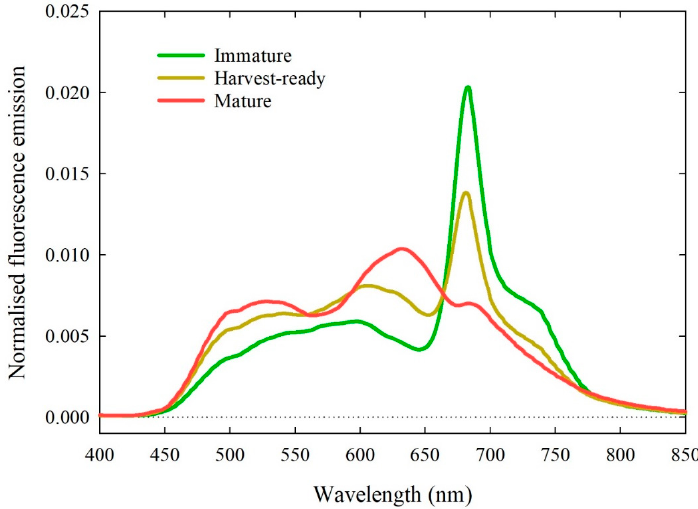
Figure 3. Normalised fluorescence emission spectra for three individual ‘August Flame’ fruit at di ff erent maturity classes. Immature: Index of absorbance di ff erence (I AD ) > 1.3; harvest-ready: 1.3 ≤ I AD ≤ 0.7 and mature = I AD < 0.7 (see Table